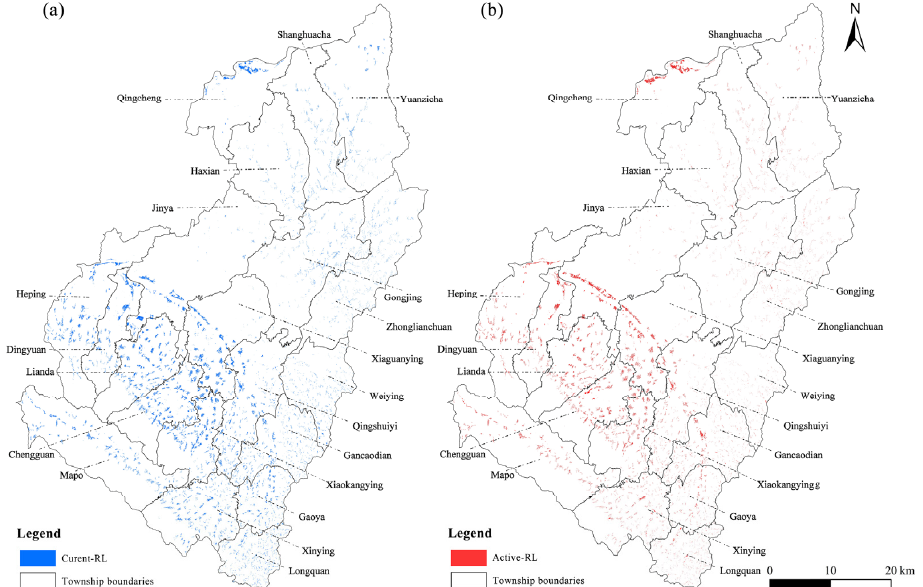
Figure 4. The current situation of the rural residential land in Yuzhong County: ( a ) the distribution of the residential land in the third land use survey data; ( b ) the distribution of the confirmed rural residential land.